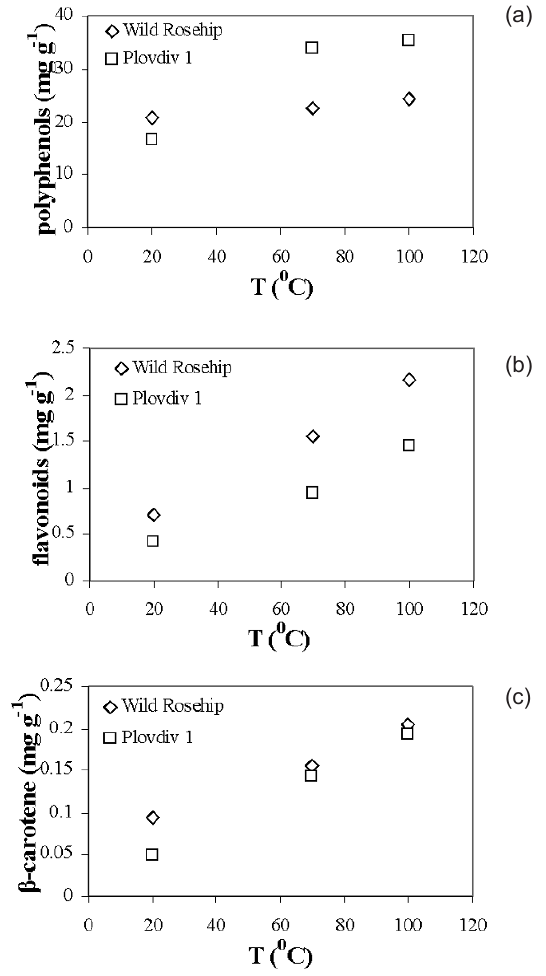
Figure 6. Yield of target compounds at different temperature, 1 hour water extraction.